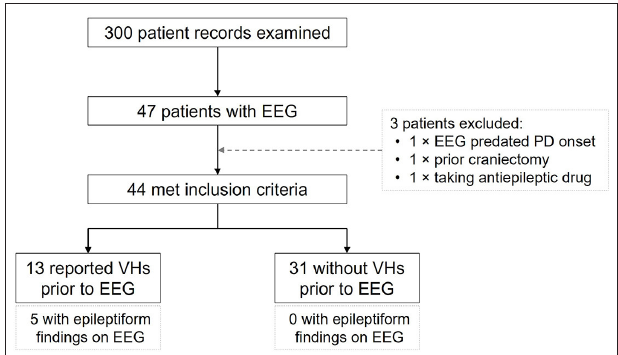
FIGURE 1 | Patient selection/exclusion and incidence of epileptiform activity on